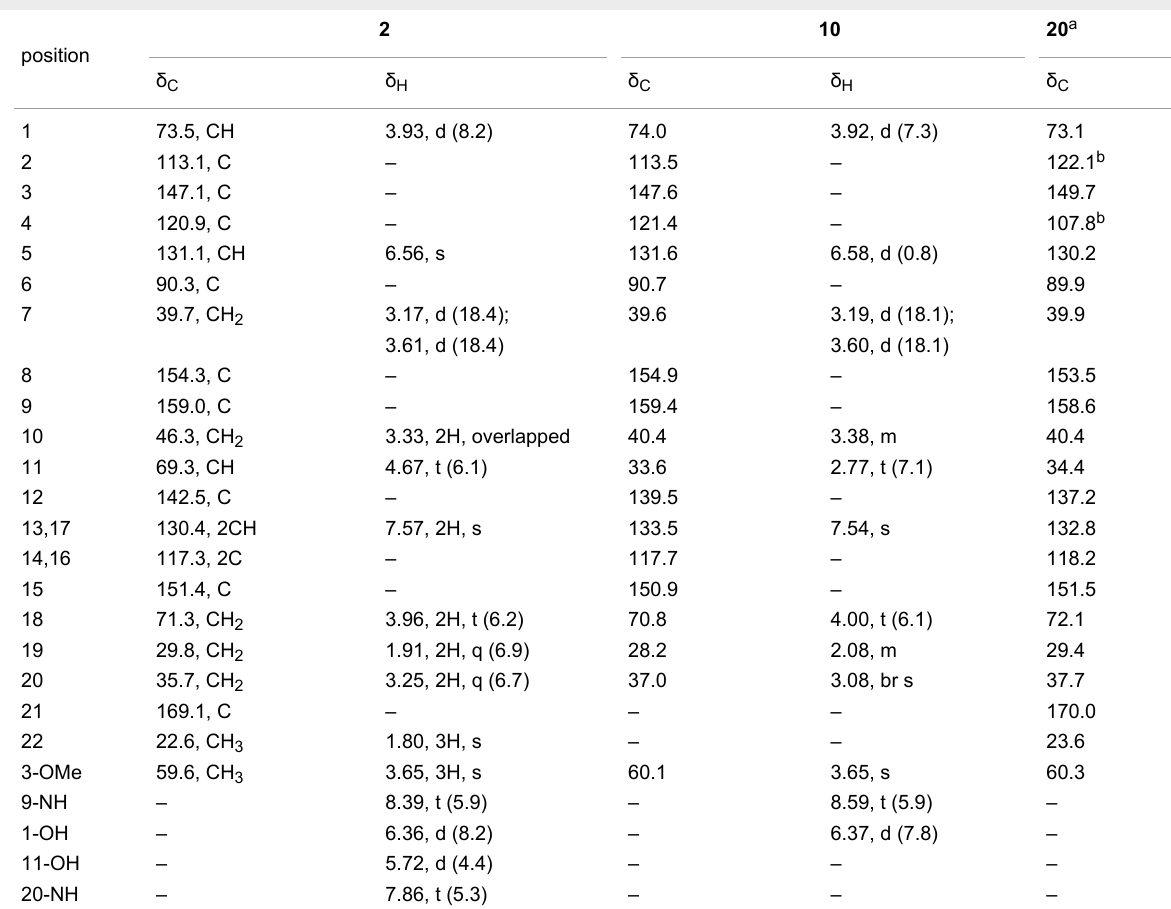
Table 3: NMR data (600 MHz, DMSO- d 6 ) of aplysinin A ( 2 ), hexadellin B ( 10 ), and diacetylhexadellin B ( 20 ).